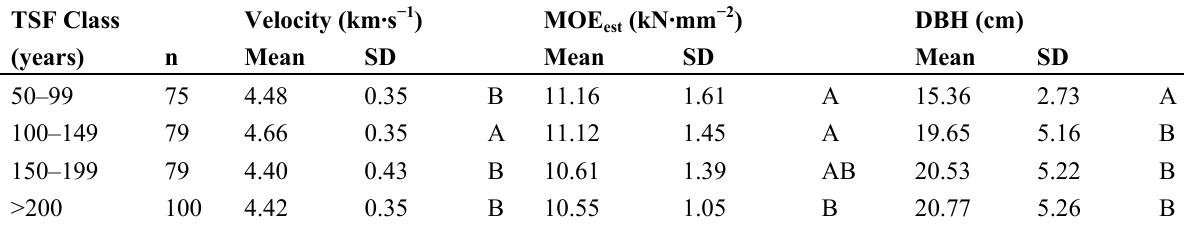
Table 1. Mean and standard deviation of acoustic velocity (tree level) and MOE (15% MC) for each TSF class (n = 333). Identical letter codes indicates no significant difference in means between TSF classes in Tukey HSD tests ( α = 0.05).